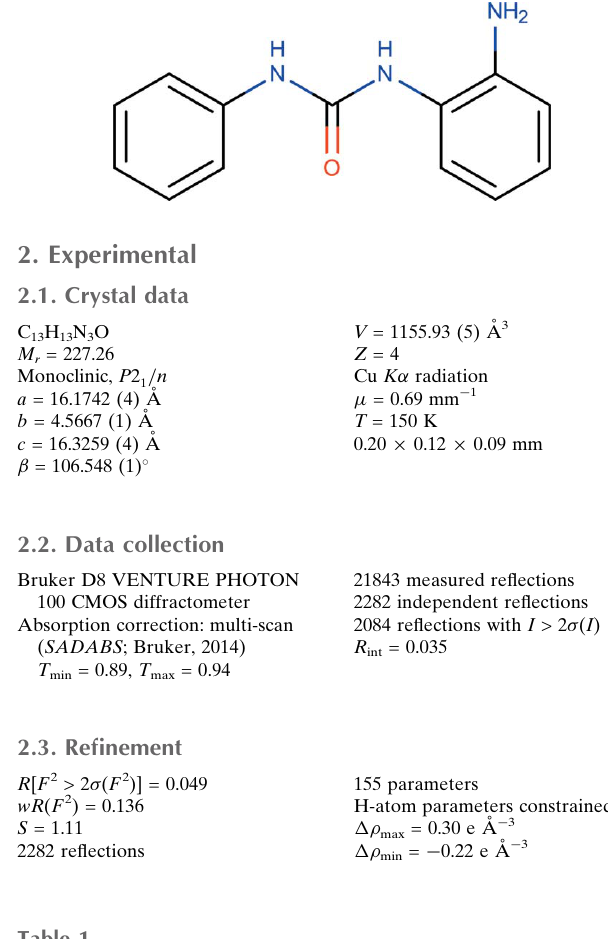
Hydrogen-bond geometry (A˚ , (cid:2)